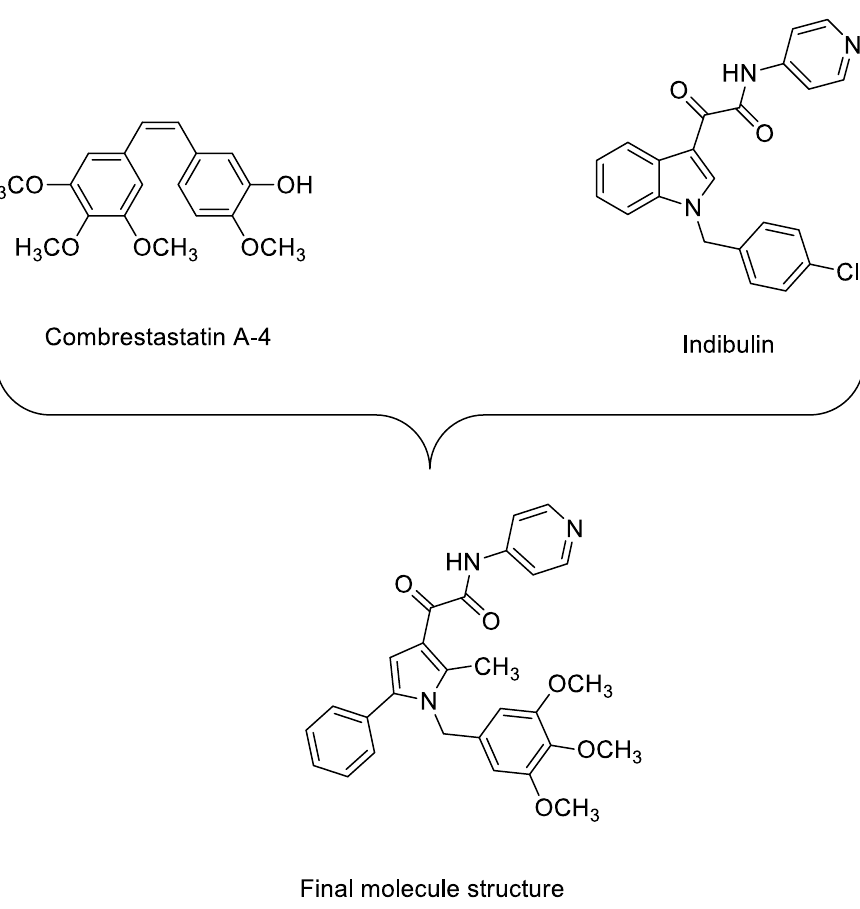
Figure 3. Structure of the designed and synthesized molecule in the current work.